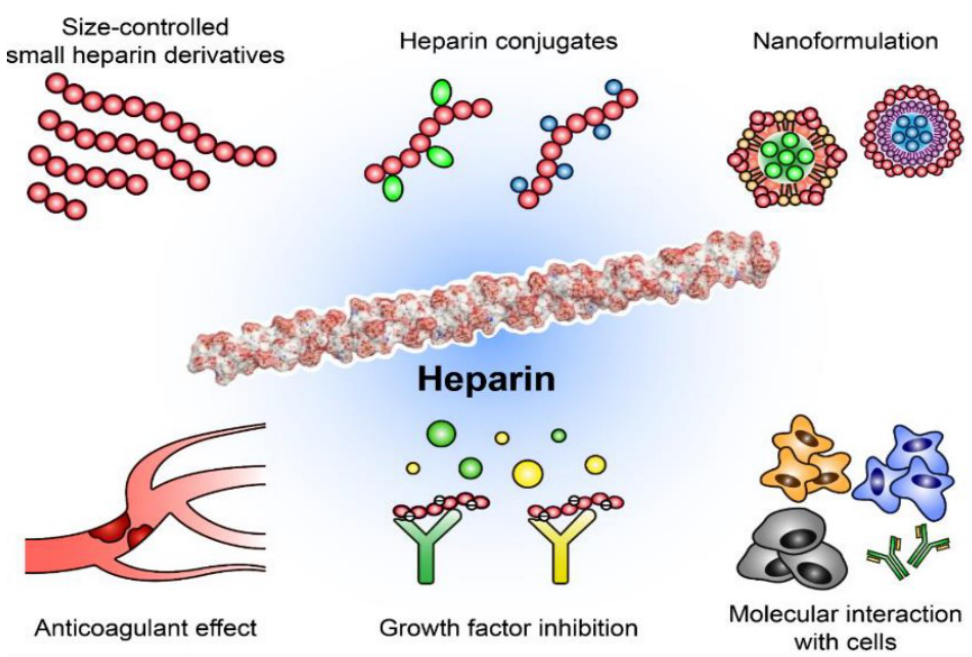
Figure 2. Schematic illustration of heparin and its derivatives applications. Reproduced with permission of MDPI from [188].